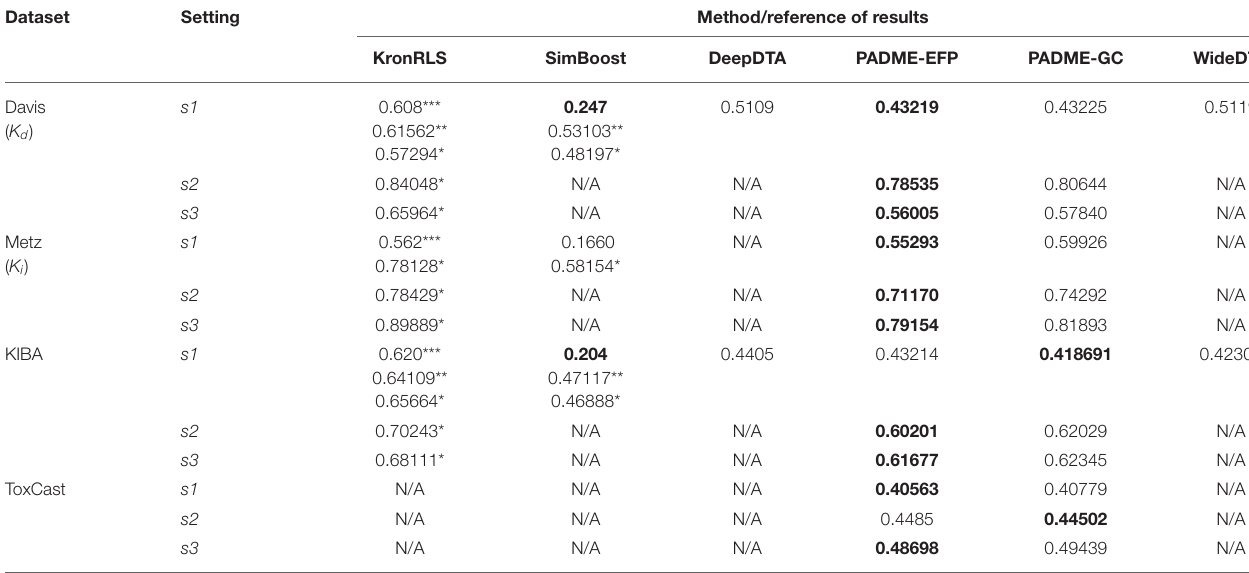
TABLE 2 | RMSE calculated using multiple settings for all baseline methods.